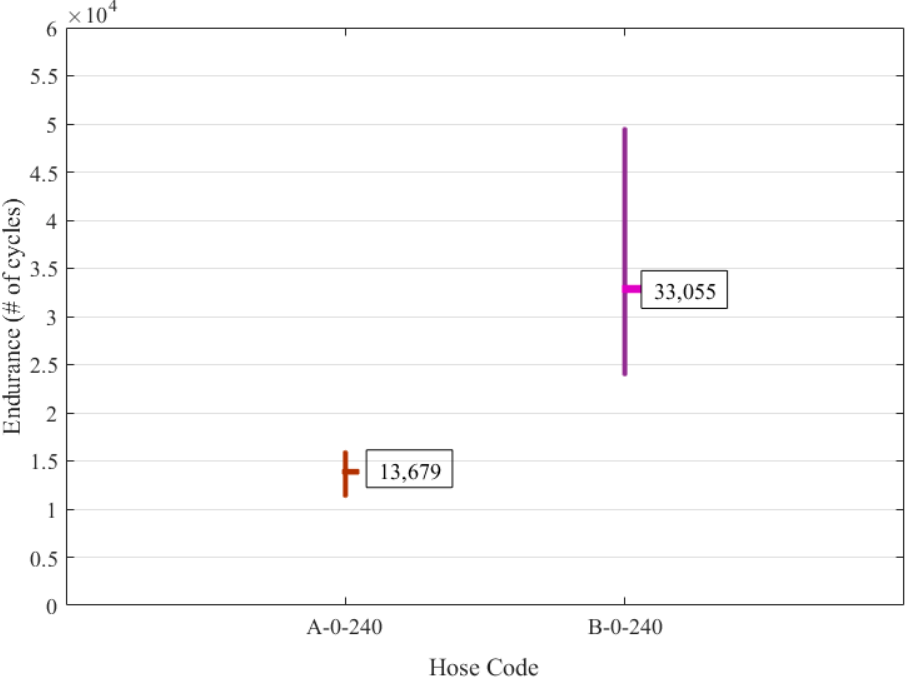
Figure 11. Influence of design in the hose endurance: average, minimum, and maximum number of cycles.